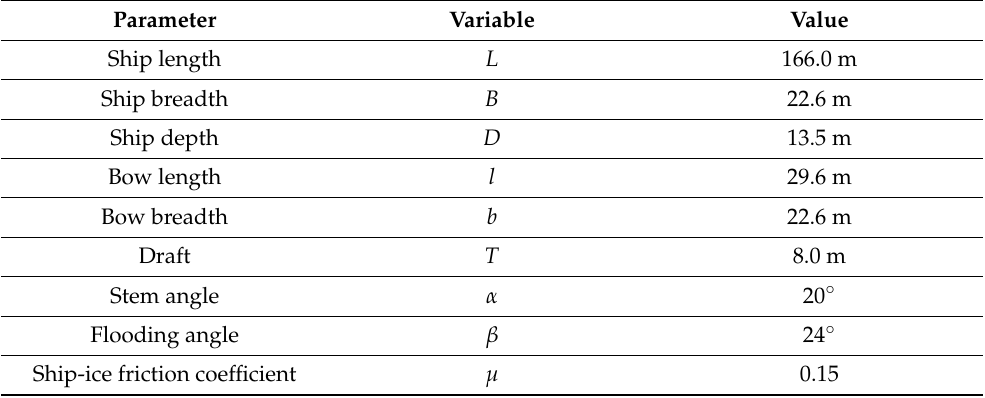
Table 2. Main parameters of icebreaker.